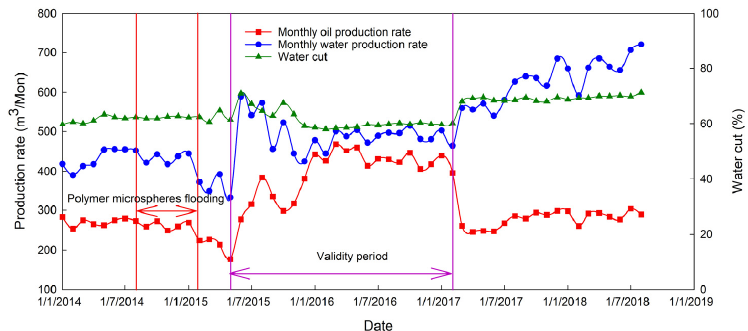
Figure 14. Monthly oil and water production rate and water